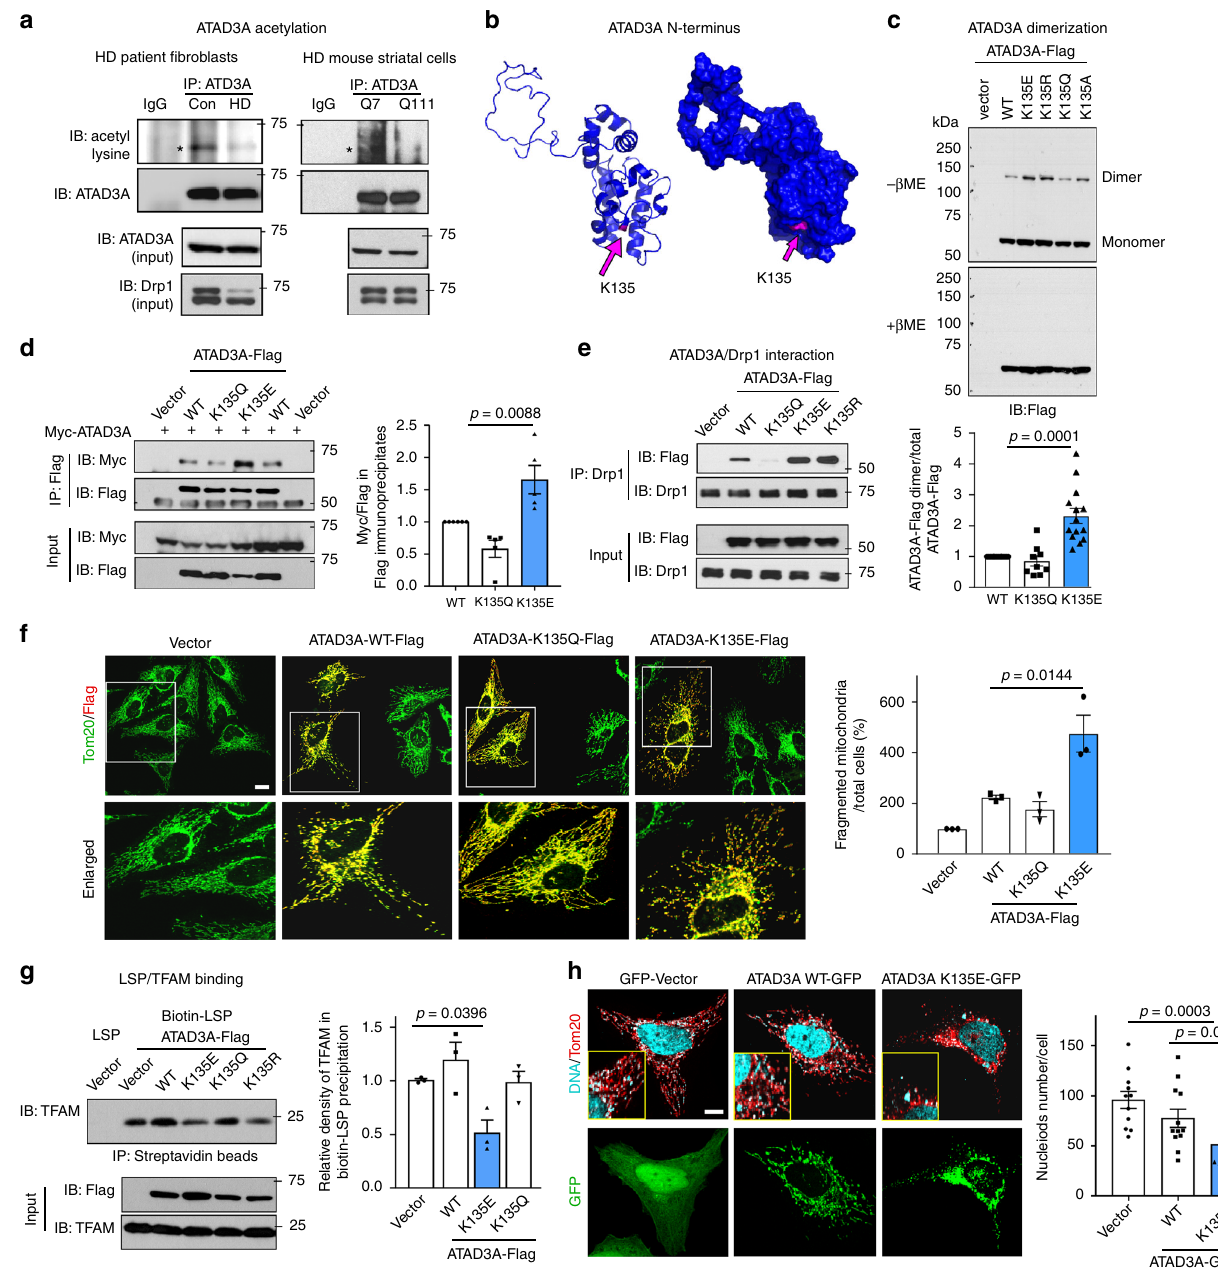
Fig. 4 ATAD3A deacetylation. a Total cell lysates of HdhQ7 and HdhQ111 cells or fi broblasts of HD patient and control subjects were subject to IP with anti-ATAD3A antibodies followed by WB with anti-acetyl lysine antibodies. Asterisks (*) indicates the acetylated ATAD3A. b ATAD3A K135 in peptide 130-AQYADLLAR-138 in human (K134 in mouse) was identi fi ed as an acetylated site (also see Supplementary Fig. 6A). The K135 labeled in pink is present on the surface of ATAD3A N-terminus simulated structure. HEK293 cells were transfected with the indicated Flag-tagged K135 mutants or ATAD3A WT for 48 h. c ATAD3A dimers were analyzed by WB in the presence or absence of β -ME. Histogram: the quanti fi cation of relative density of ATAD3A dimer in the absence of β -ME versus total protein level under reduced conditions. At least 6 independent experiments, one-way ANOVA with Tukey ’ s post-hoc test. d Immunoprecipiates with anti-Flag antibodies were analyzed with anti-Myc antibodies. Histogram: the quanti fi cation of relative density of Myc- ATAD3A/ATAD3A-Flag in the immunoprecipitates. Five independent experiments, one-way ANOVA with Tukey ’ s post-hoc test. e IP of total protein lysates was performed with the indicated antibodies. f HeLa cells were transfected with Flag-ATAD3A WT or K mutants for 48 h. Cells were stained with anti-Tom20 (green) and anti-Flag (red) antibodies. Mitochondrial morphology was imaged. Scale bar: 10 µ m. Histogram: the percentage of cells with fragmented mitochondria to total number of cells. Three independent experiments, one-way ANOVA with Tukey ’ s post-hoc test. g The binding of TFAM and biotinylated mtDNA LSP probe was determined by biotin-streptavidin pull down. Histogram: the relative density of TFAM in the Biotin-LSP precipitates. Three independent experiments, one-way ANOVA with Tukey ’ s post-hoc test. h HeLa cells were stained with anti-Tom20 (red) and anti-DNA (blue) antibodies at the indicated groups. The co-localization of DNA and Tom20 was analyzed by confocal microscopy. Insert: the enlarged images. Scale bar: 10 µ m. The number of nucleoids immunopositive for both anti-DNA and anti-Tom20 was quantitated by NIH Image J software. Three independent experiments, one-way ANOVA with Tukey ’ s post-hoc test. All shown blots are from at least 3 independent experiments. Data are mean ±